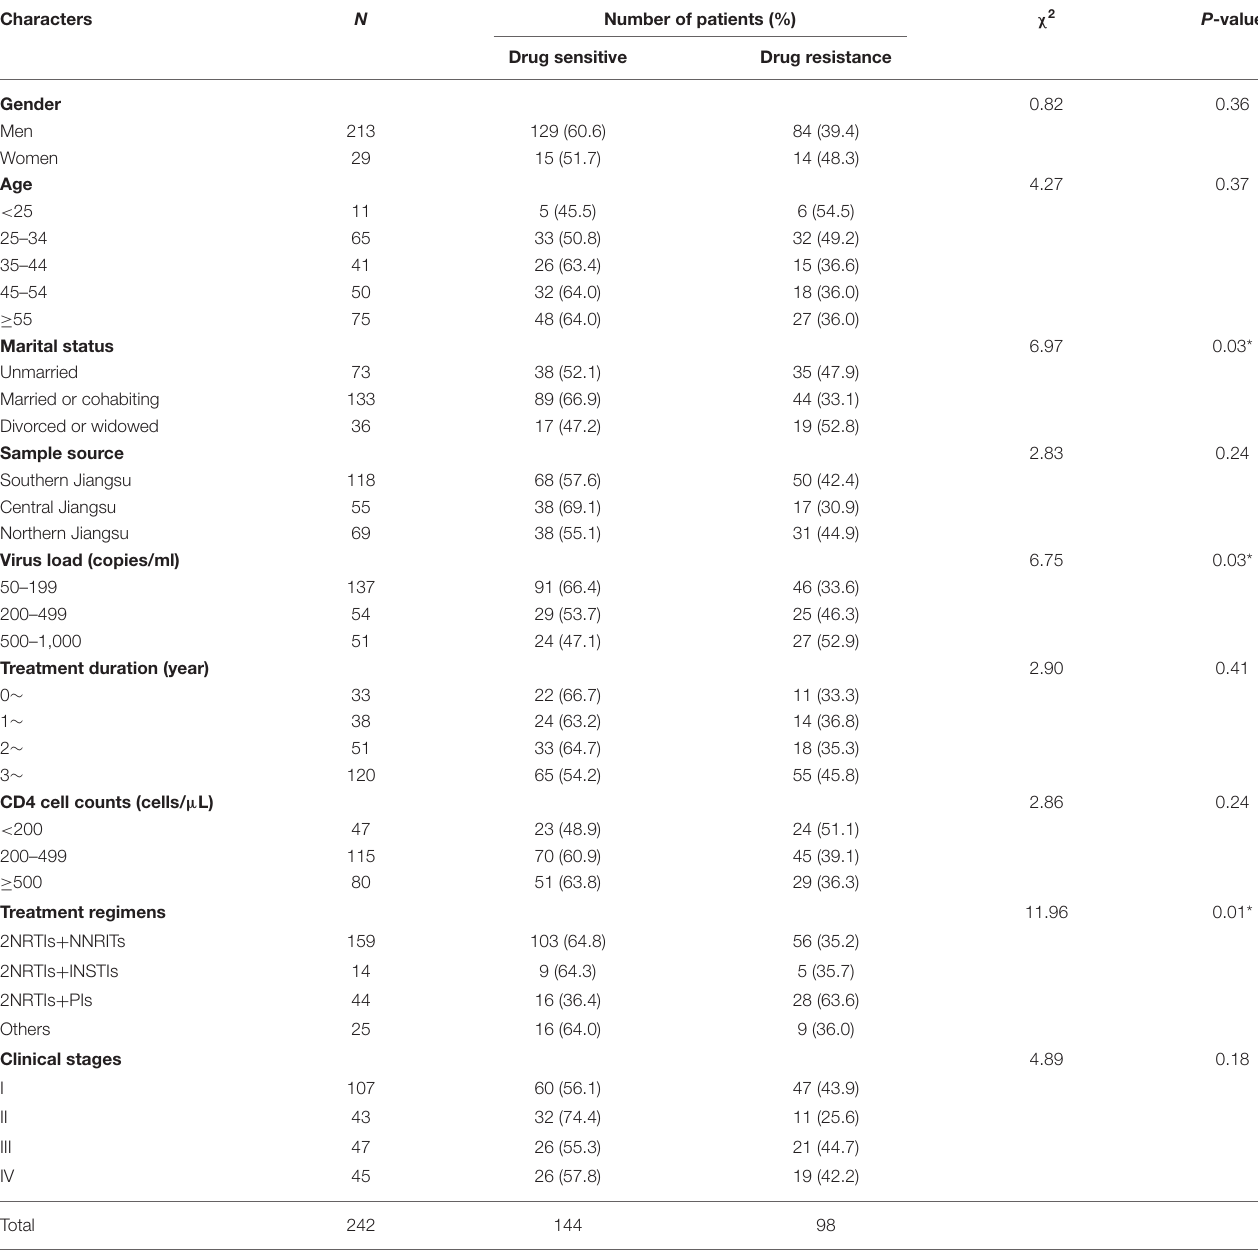
TABLE 2 | Characteristics of LLV